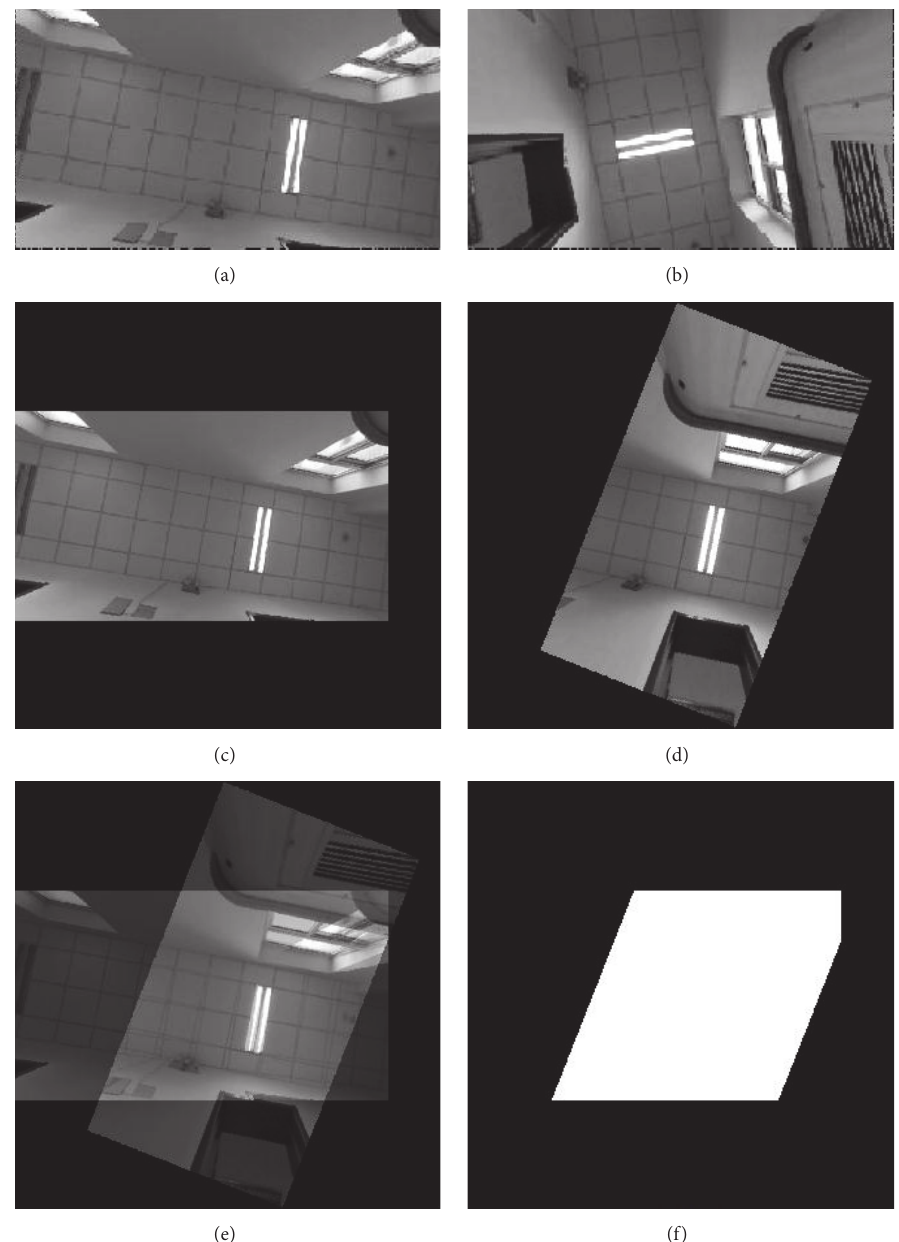
Figure 4: The overlap region extraction progress. (a) Frame 𝐴 , (b) Frame 𝐵 , (c) the translation result, (d) the rotation result, (e) the overlap between two frames, and (f) the overlap region